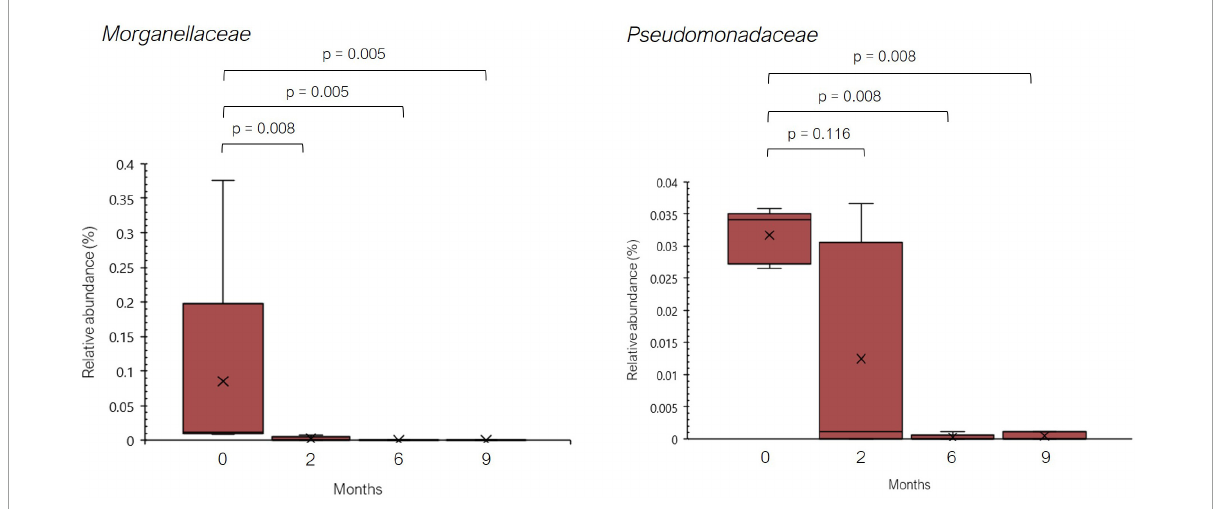
FIGURE4 Relative abundance (%) of Morganellaceae and Pseudomonadaceae observed in histamine intolerant patients during the dietary treatment. Mean values are indicated by an × . p < 0.05 indicates statistically significant